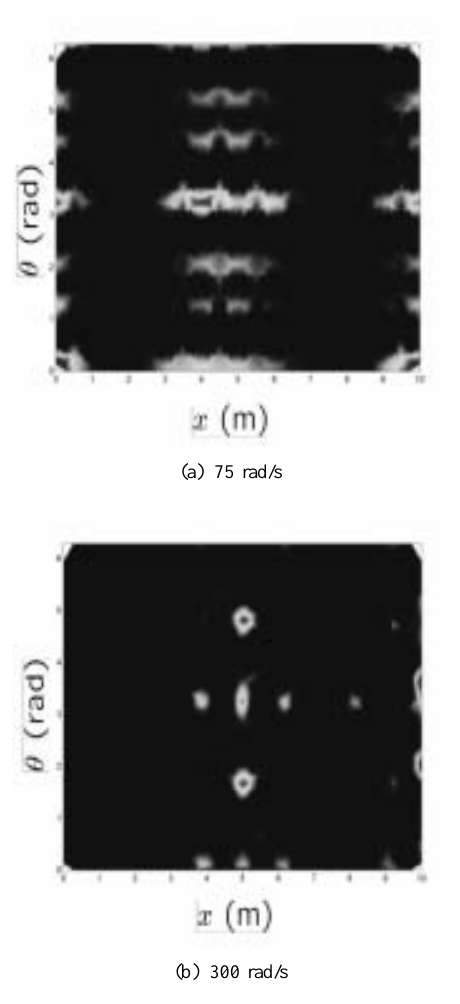
Fig. 12. Harmonic response for hexagonal grid with β = 30 ◦